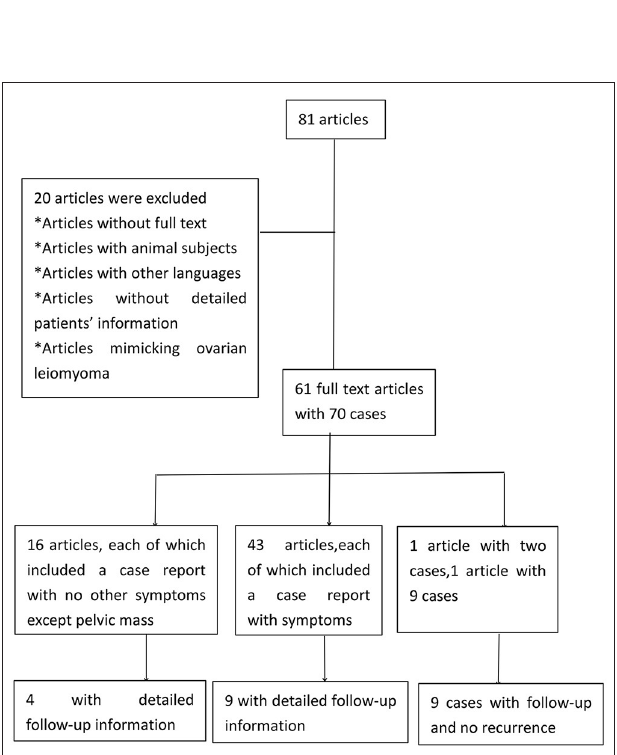
FIGURE 3 | The histological images of case 5. Histological test results demonstrated ovarian leiomyoma with smooth muscle actin (SMA) positive and mitosis in 4/10 high-powered fields (H&E, original magnification 400 × ). FIGURE 4 | Chart of the literature electronic search of ovarian